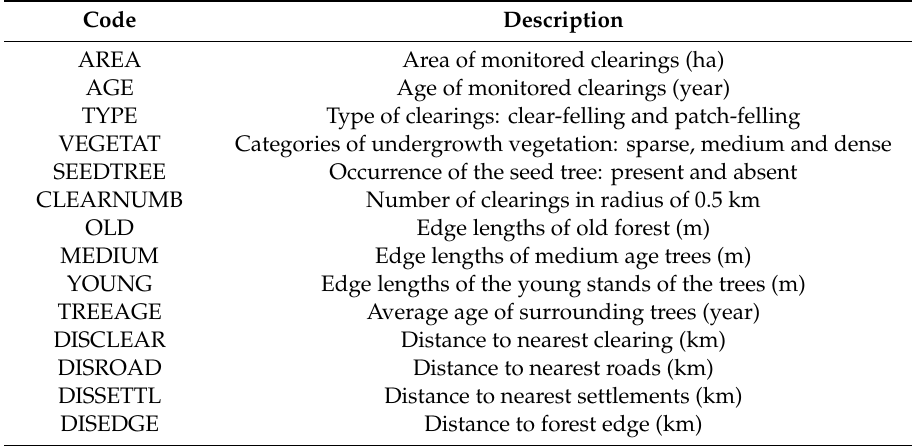
Table 1. Habitat variables taken into consideration for analyzing the choice of breeding territories by Nightjars Caprimulgus europaeus . Code